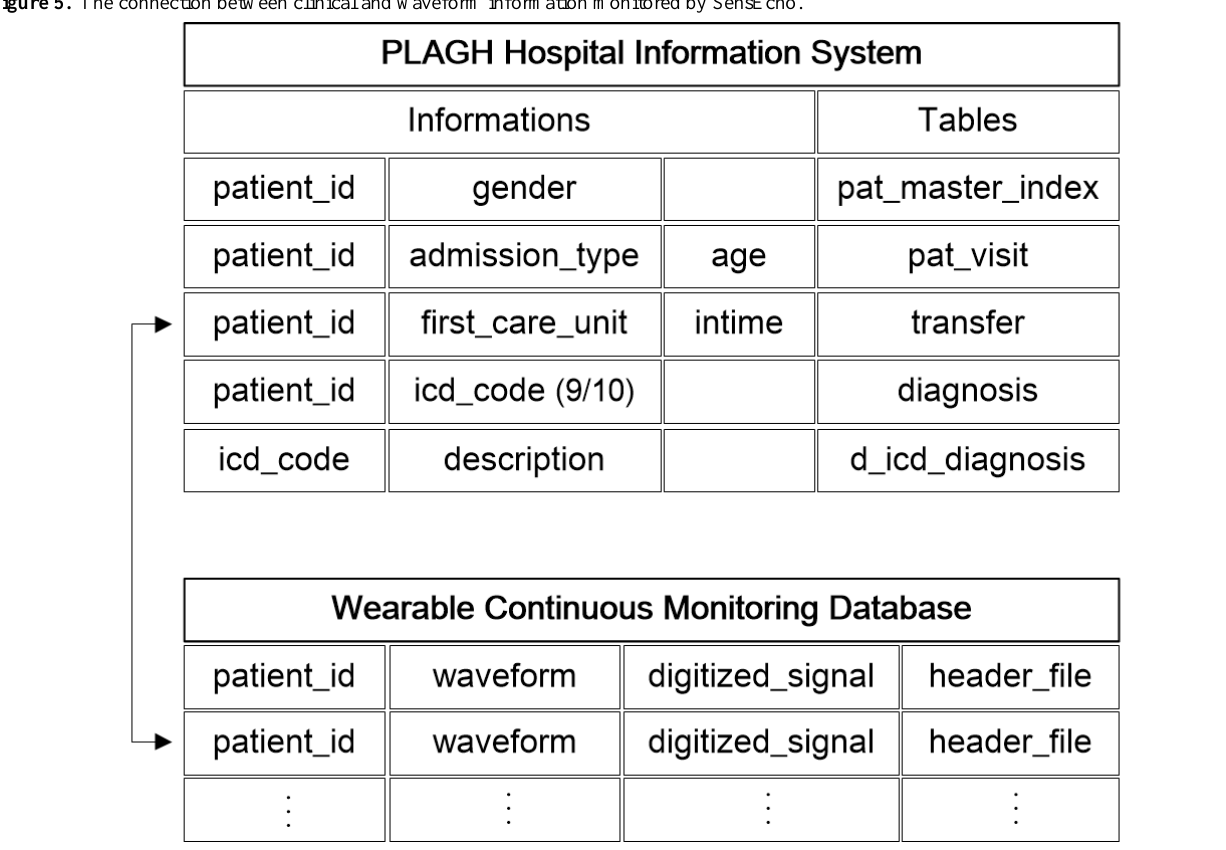
Figure 5. The connection between clinical and waveform information monitored by